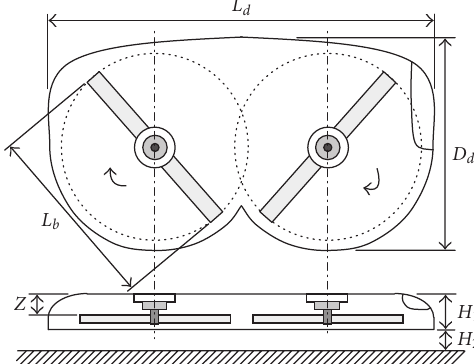
Figure 1: Schematic diagram of discharge-type mower deck Model I.